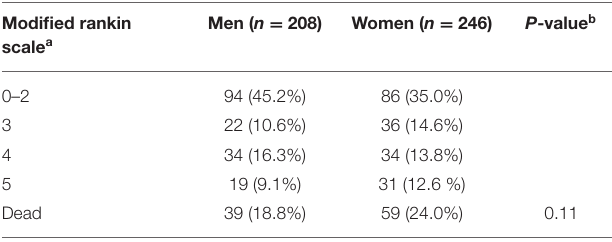
TABLE 3 | Functional status 90 days after mechanical